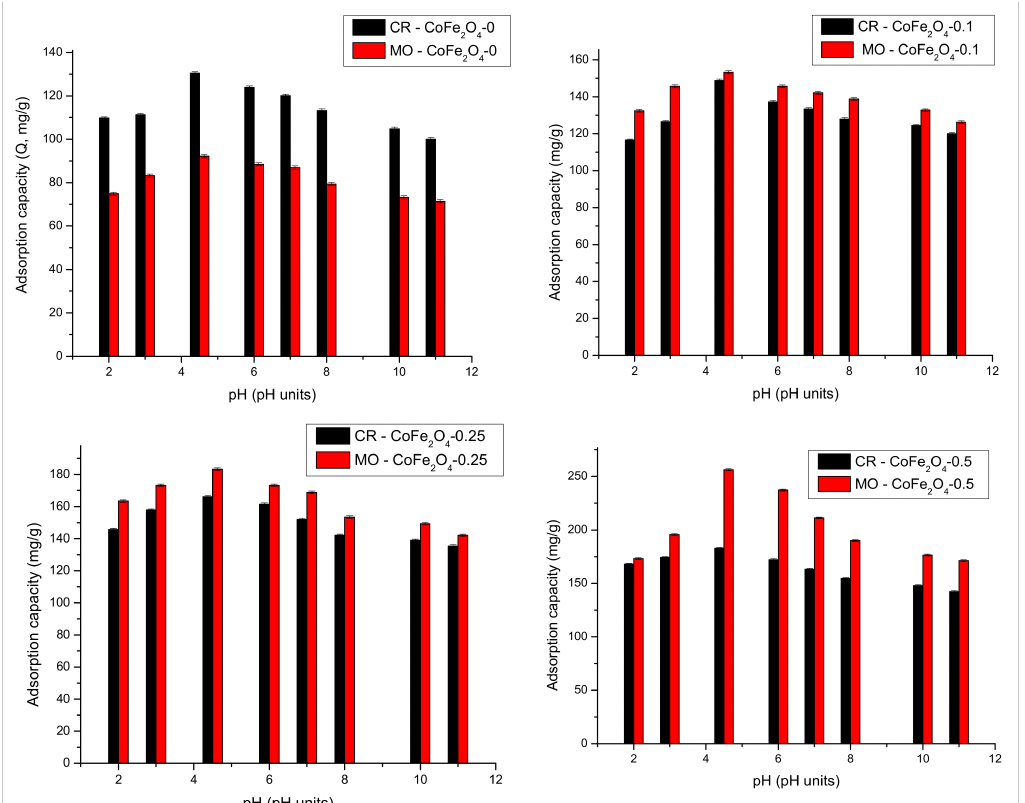
Figure 18. Effect of pH on adsorption capacity of CoFe 2 O 4 samples for CR/MO from single